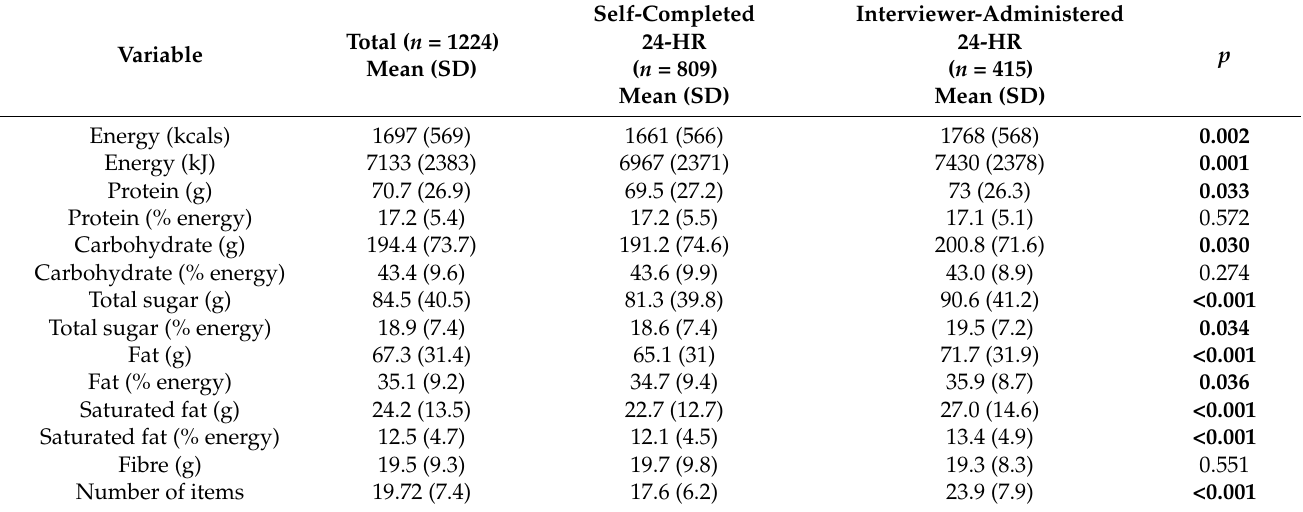
Table 3. Energy and nutrient intake and number of items reported, by 24-HR completion method (self-completed and interviewer-administered).